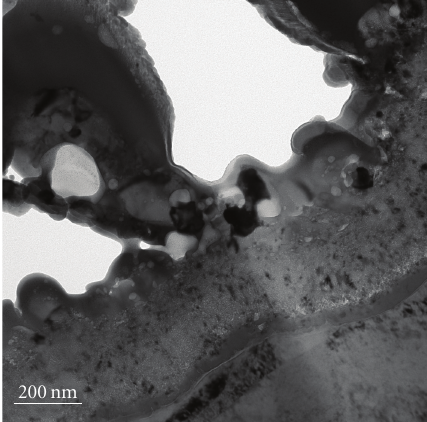
Figure 5: Cross-sectional TEM micrograph of the mTiO 2 film in which the porous TiO 2 was formed on a 300 nm-thick TiO 2 layer supported by Ti substrate. Figure 6: Di ff used reflection spectra of the mTiO